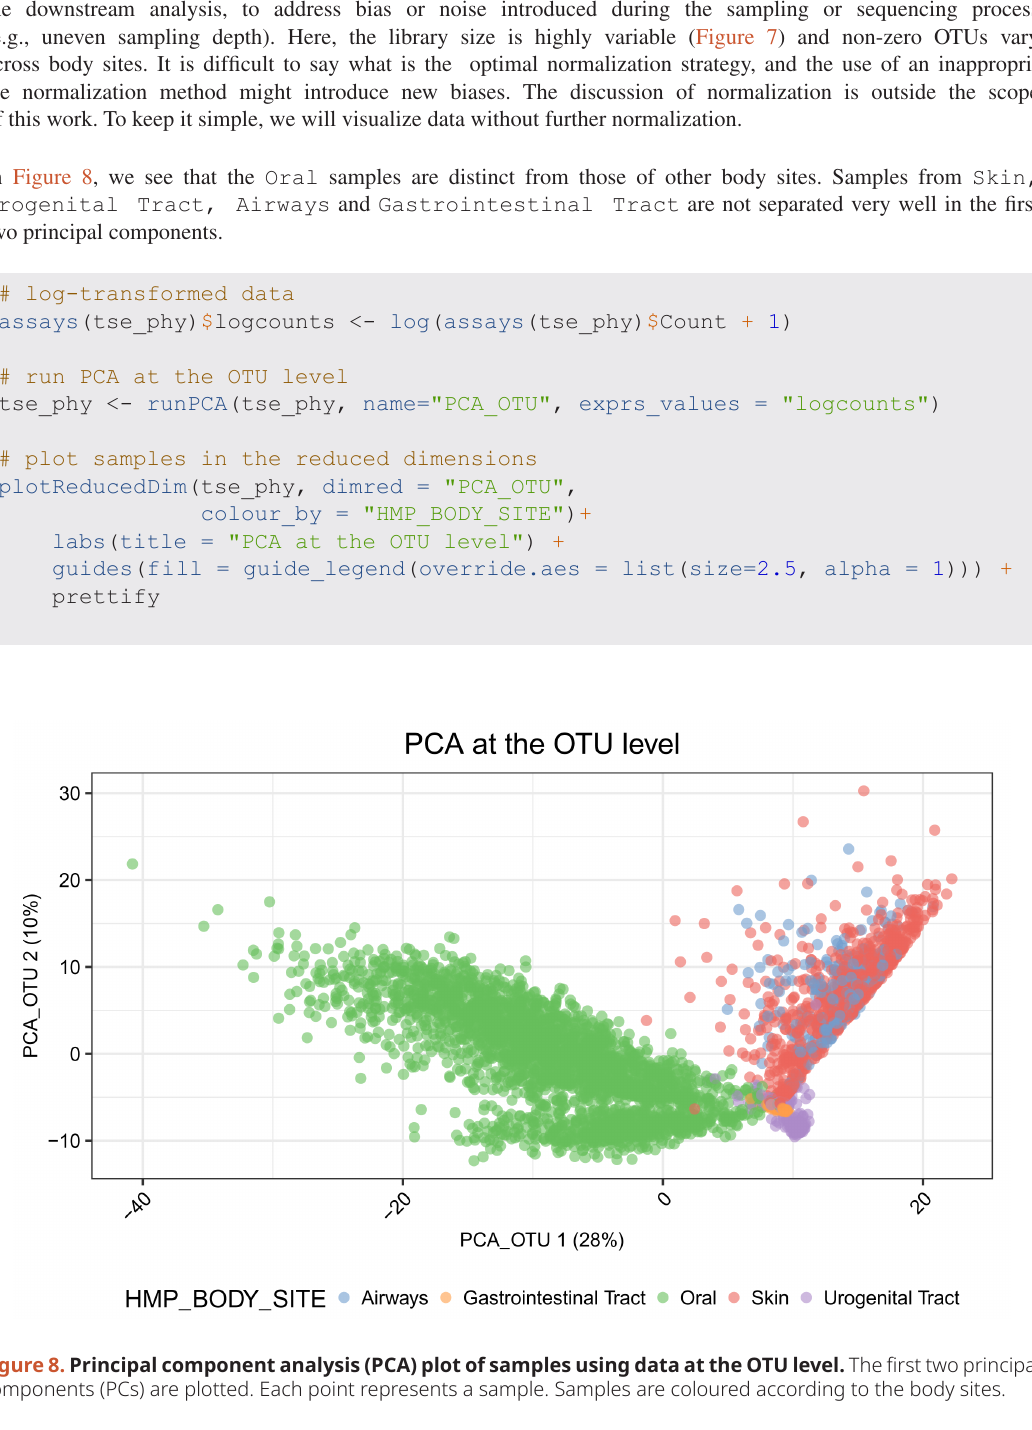
OTU level, and select the one better clustering the samples to apply on data aggregated at coarser taxonomic levels to see whether the resolution affects the separation of